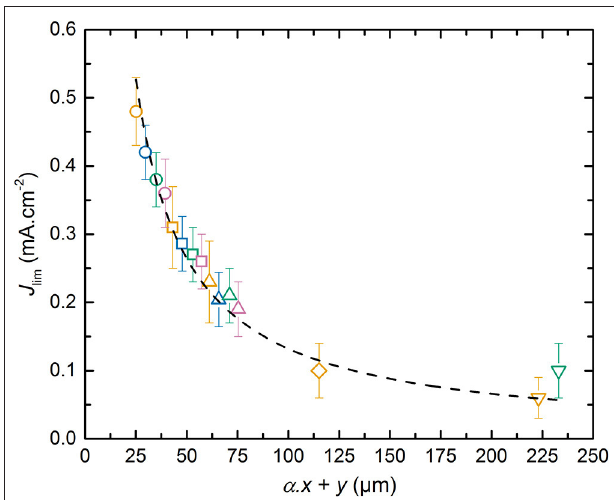
FIGURE 6 | Limiting current density, J lim , as a function of α . x + y . The dashed curve corresponds to the fit obtained using a reciprocal function. The symbols correspond to SPE thickness y of ( (cid:13) ) 18, ( 2 ) 36, ( △ ) 54, ( ♦ ) 108, and ( ∇ ) 216 µ m. The symbol colors correspond to positive electrode thickness x of (orange) 20, (blue) 33, (green) 48, and (pink) 60 µ